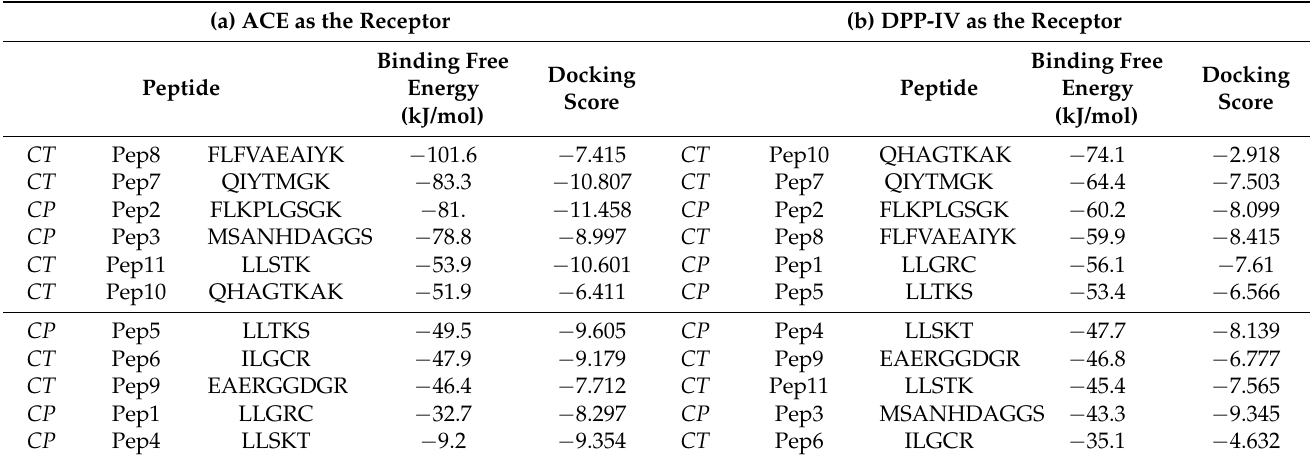
Table 2. Binding free energy values and docking score of the best poses obtained by the application of the computational protocol on the Chlorella-derived peptides interacting with ( a ) ACE and ( b ) DPP-IV targets. (a) ACE as the